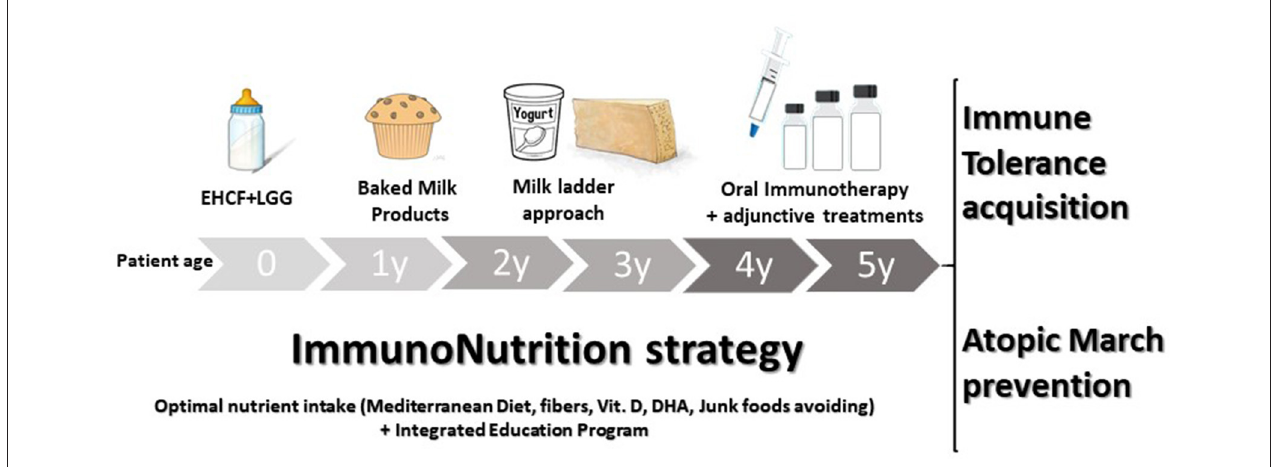
FIGURE 3 | The immunonutrition strategy in cow’s milk allergy (CMA) children. The active diet approach could start, in non-breastfed infants, with extensively hydrolyzed casein formula (EHCF) supplemented with the probiotic Lactobacillus rhamnosus GG (LGG). Then, if immune tolerance is not achieved in the first years of the disease, all the depicted steps should be considered to stimulate immune tolerance acquisition and to prevent the occurrence of other allergic manifestations. During the CMA course, the promotion of the Mediterranean diet, as well as vitamin D, calcium, and docosahexaenoic acid (DHA) supplementation should be evaluated based on the formula choice, age, and total formula daily intake. Lastly, an integrated education program aiming to limit any potential negative environmental factor exposure should be provided.